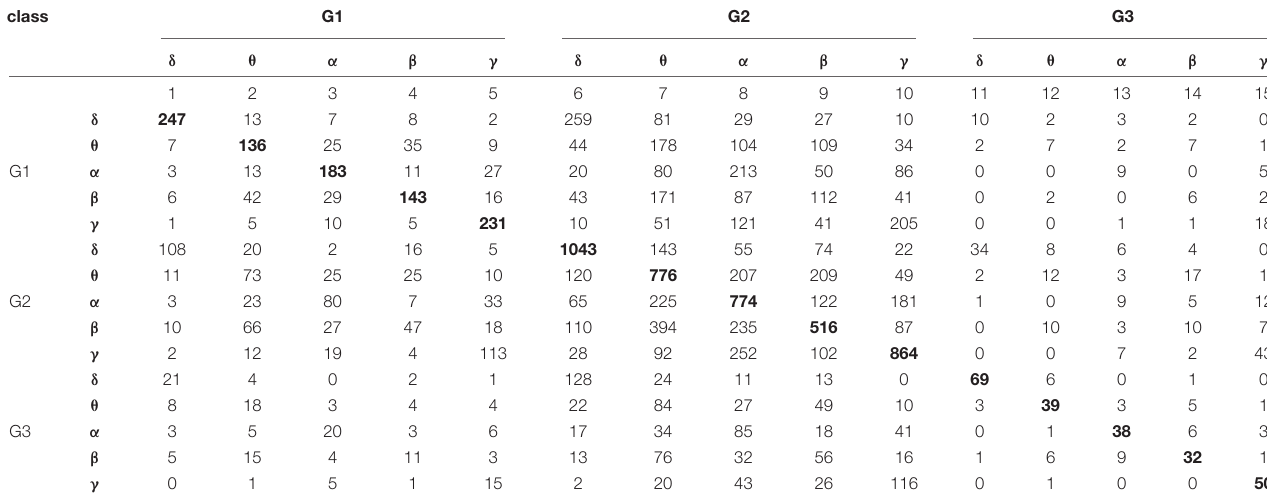
TABLE 4 | The results of classification based on the k -NN rule and the leave-one-out method by 15 classes formed from all possible combinations of the three stimulation protocols and five frequency bands.